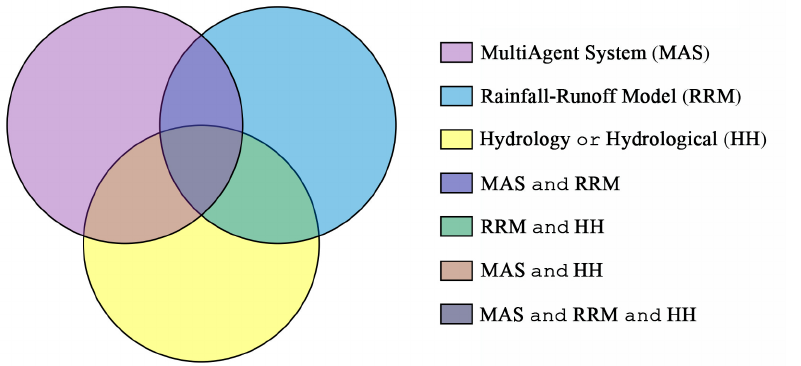
Figure 4. Diagram of keywords.